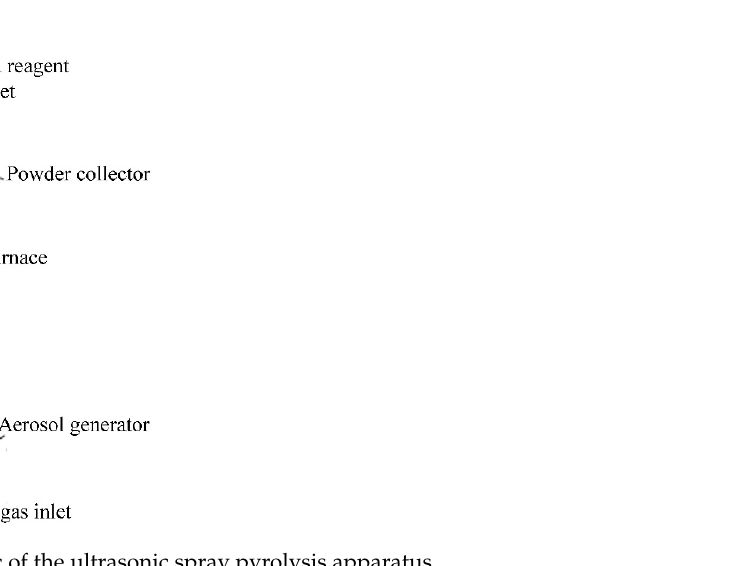
Figure 1. Schematic of the ultrasonic spray pyrolysis apparatus.